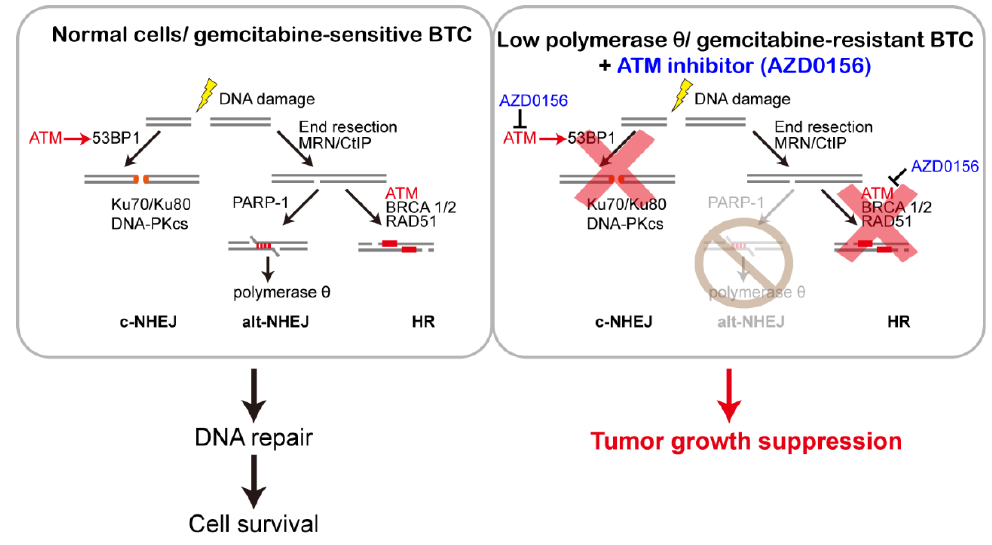
Figure 8. A diagram illustrating that the ATM inhibitor AZD0156 impairs tumor growth in gemcitabine-resistant or polymerase θ-deficient BTCs. gemcitabine-resistant or polymerase θ -deficient